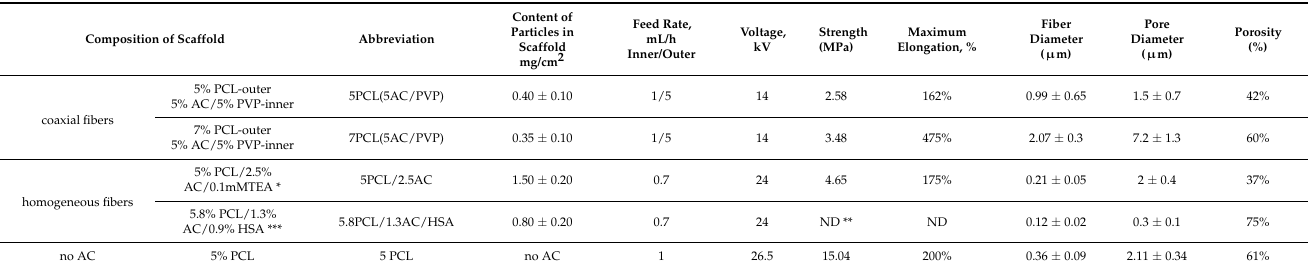
Table 4. Electrospinning conditions and physical properties of the